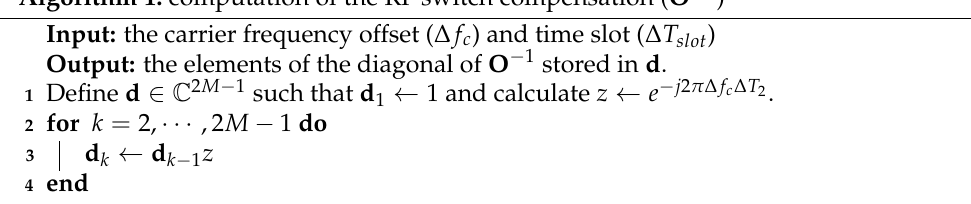
Algorithm 1: computation of the RF switch compensation ( O − 1